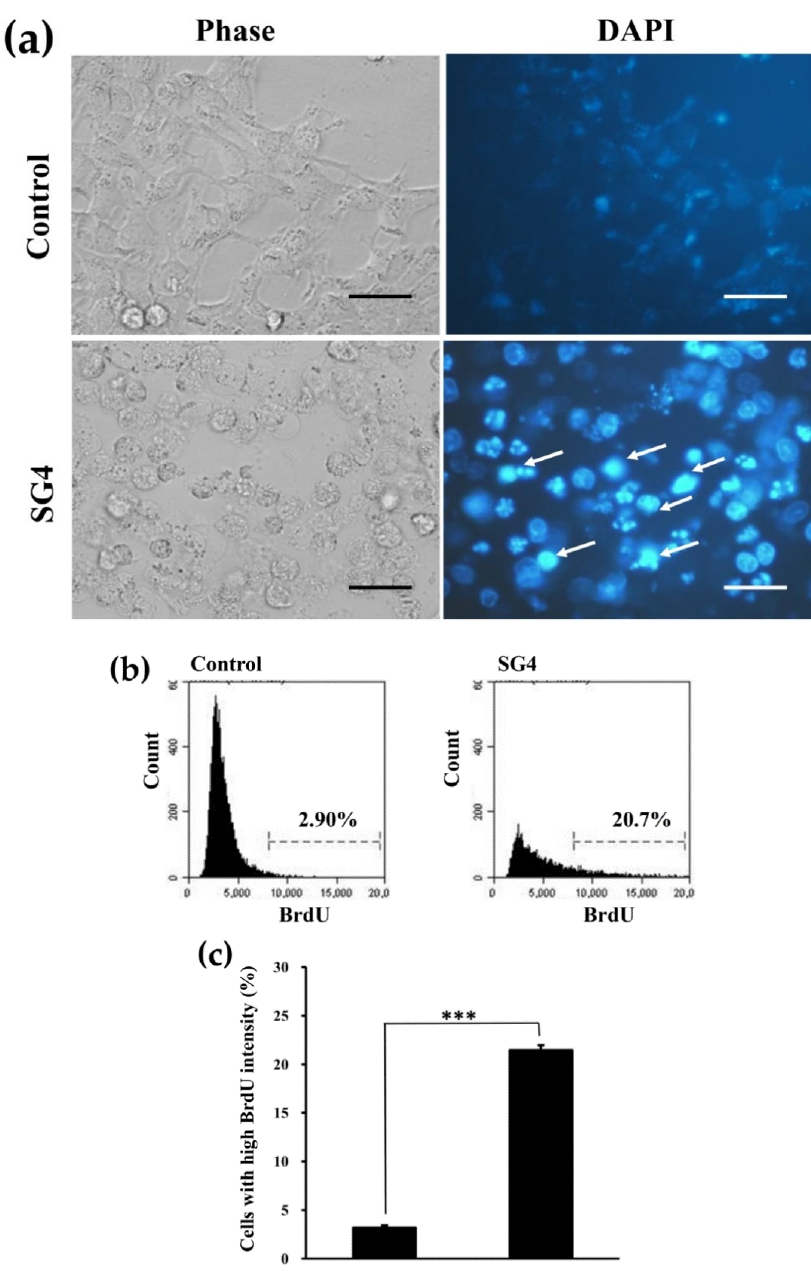
Figure 5. The induction of chromatin condensation and DNA fragmentation in HT-29 cells treated with 200 µ g / mL SG4 for 48 h: ( a ) Morphological and DAPI-staining assessments of HT-29 cells treated with 200 µ g / mL SG4 for 48 h. Arrows in the graph indicate nuclear condensation (bright blue) (scale bar, 50 µ m). ( b ) In the histograms, x axis and y axis denote BrdU content and cell counts, respectively. The percentage of cells with mean channel fluorescence values above the marker border is indicated in each histogram; ( c ) the percentage of cells with high fluorescence of BrdU is presented as determined for ( b ). The experiments were performed in triplicate. *** p < 0.001.